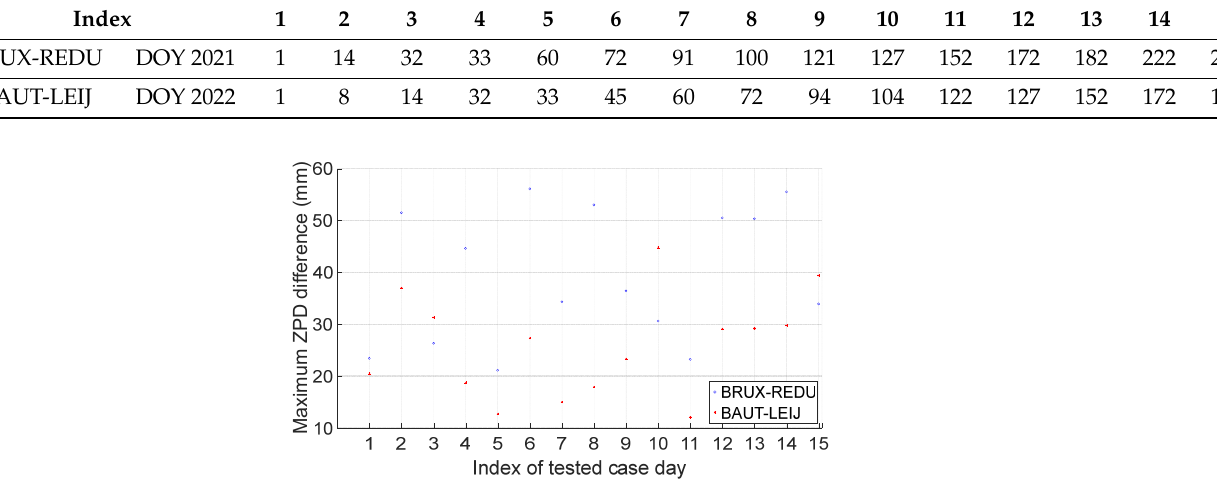
Figure 12. ZPD difference between BRUX and REDU.